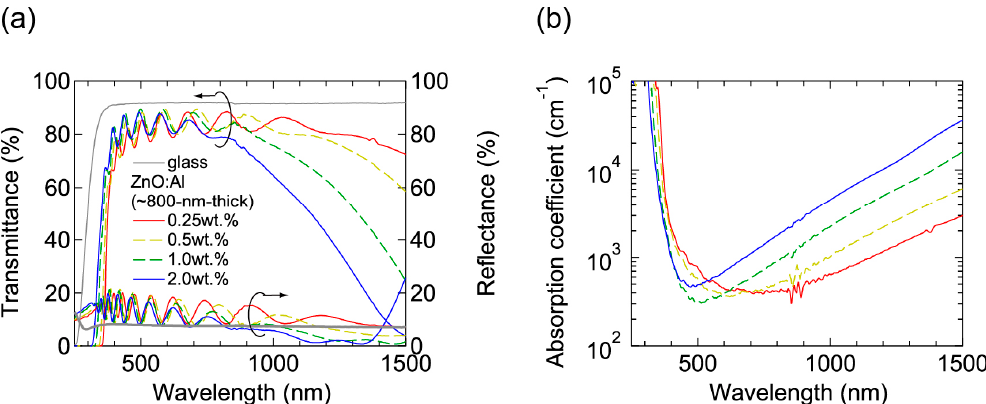
Figure 7. ( a ) Transmittance and reflectance; and ( b ) absorption coefficient spectra of the ~800-nm-thick ZnO:Al (0.25, 0.5, 1.0, and 2.0 wt %) ~800-nm-thick ZnO:Al (0.25, 0.5, 1.0, and 2.0 wt %) films.